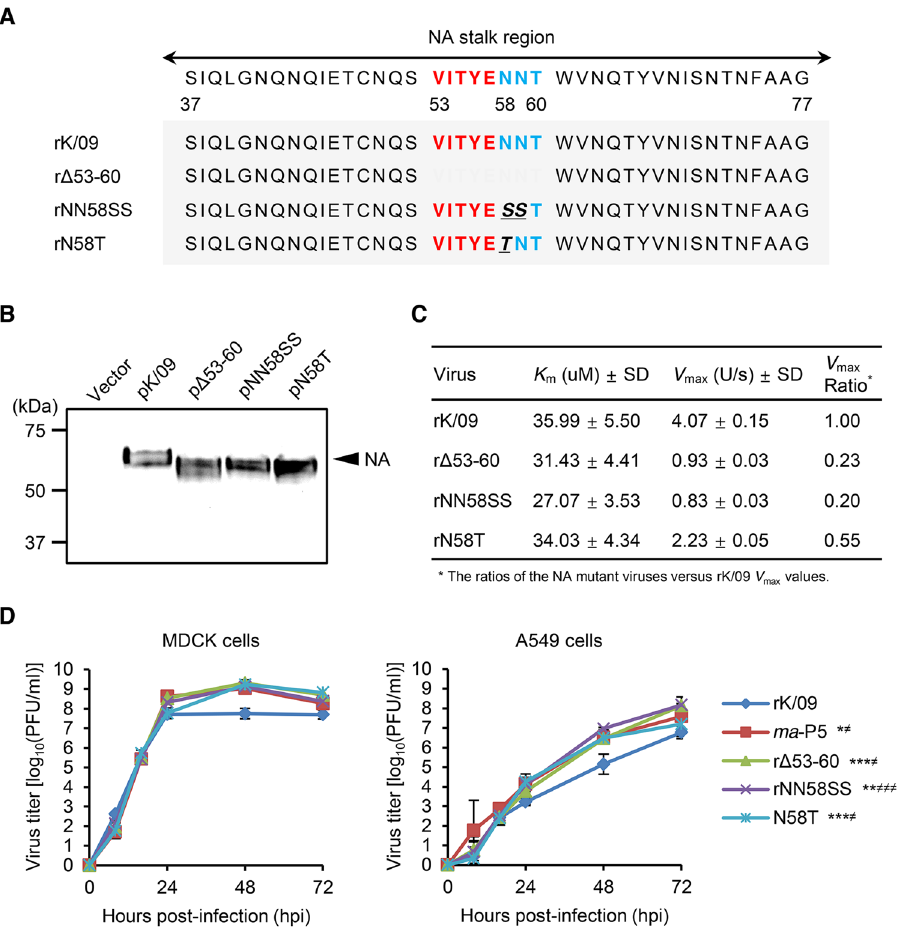
Figure 2. In vitro evaluation of the rK/09 and its NA stalk mutant viruses. ( A ) rK/09 and its NA stalk mutant viruses (r Δ 53–60, rNN58SS, and rN58T) were generated by reverse genetics based on the NA stalk truncation or deglycosylation strategy. ( B ) In the western blotting assay, NA stalk mutations (truncation and deglycosylation) were confirmed based on the mobility shift of NA proteins. ( C ) The enzyme kinetics data were fit to the Michaelis-Menten equation by nonlinear regression to determine the Michaelis constant ( K m ) and maximum velocity ( V max ) of substrate conversion. Results were given as the means ± SD from three independent determinations on triplicate samples where the R 2 was > 0.99. ( D ) Replication properties of each virus were evaluated in MDCK and A549 cells at a multiplicity of infection (MOI) of 0.001. The results were represented as the mean values from three independent experiments. Error bars denote SD. * P < 0.05, ** P < 0.01, and *** P < 0.001 for the results assessed in the MDCK cells and ≠ P < 0.05 and ≠≠≠ P < 0.001 in the A549 cells (compared with the rK/09 replication